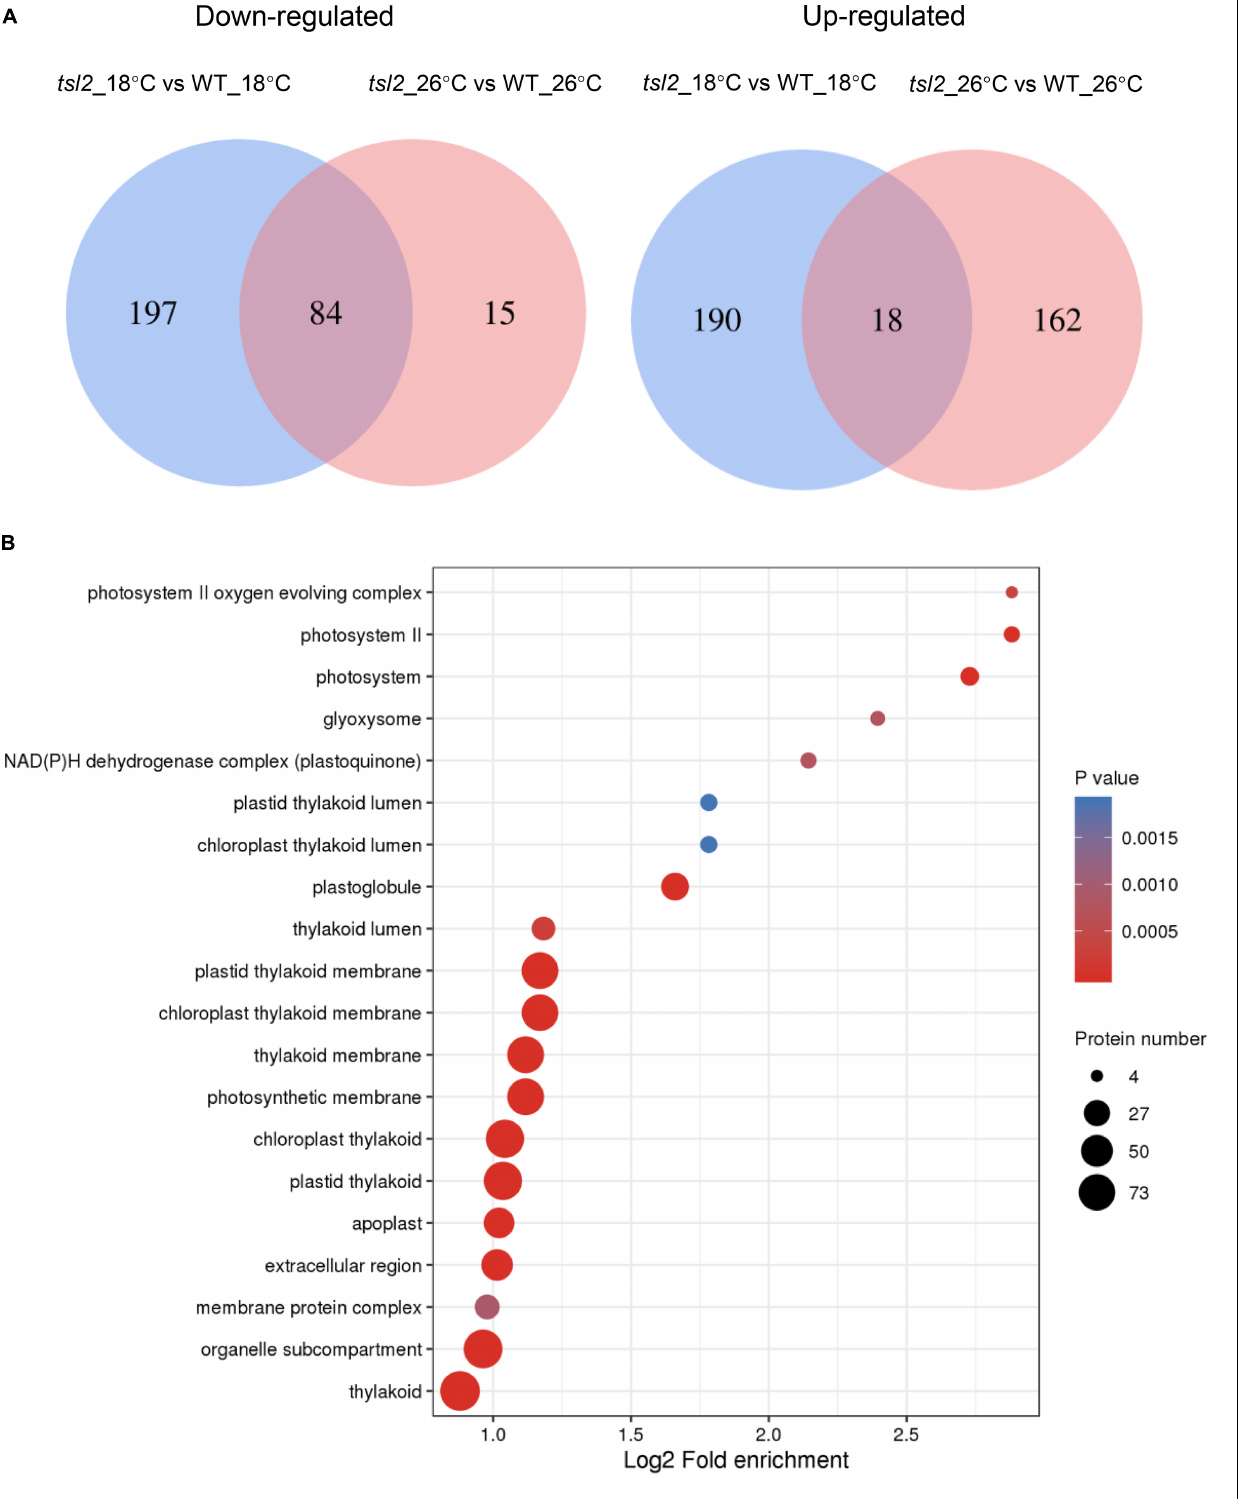
Frontiers in Plant Science |